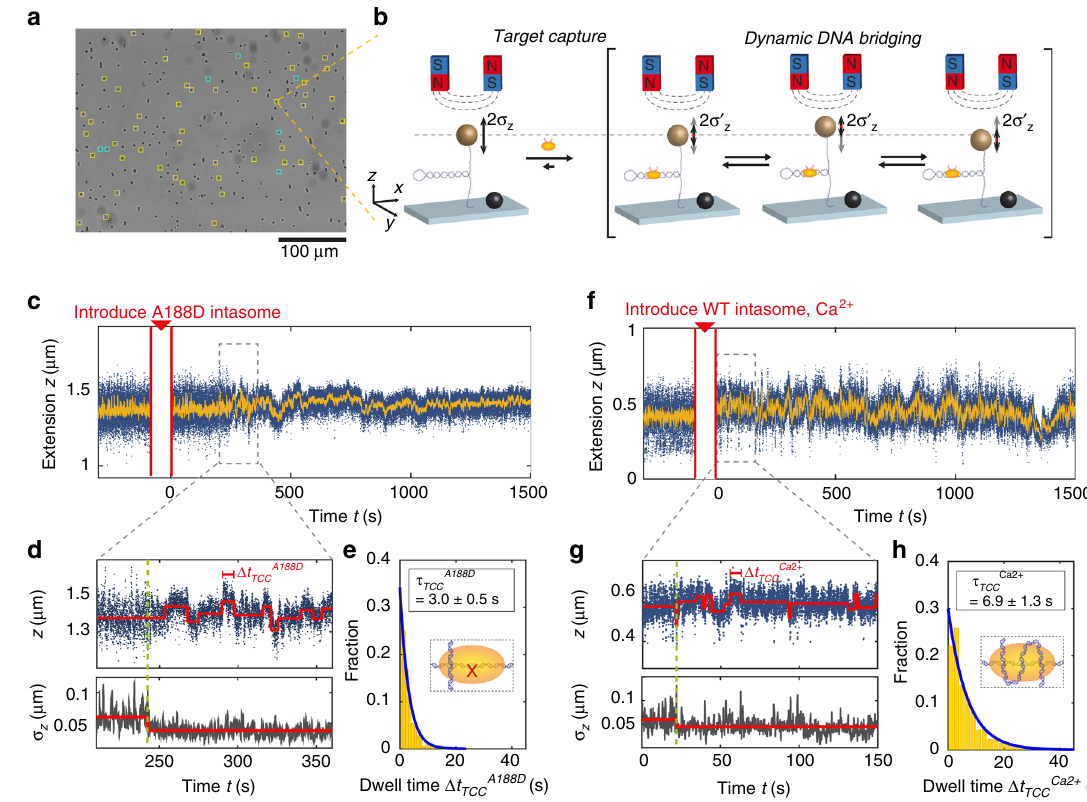
Fig. 3 Magnetic tweezers assay reveals target capture dynamics. a A typical fi eld of view depicting ~50 beads used for tracking (yellow) and reference beads (blue). b DNA tethers are supercoiled using external magnets and exhibit extension fl uctuations with SD σ z . Target capture reduces σ z via DNA bridging. Transient interface unbinding repositions intasomes thereby affecting extension. c Time trace of supercoiled target DNA extension before and after binding A188D CI intasomes (blue: raw data at 58 Hz, yellow: 1 Hz smoothed data). d Enlarged region of c highlighting the onset of dynamic bridging (green dotted line) and coinciding σ z reduction calculated with a 0.5 s moving window (red lines: trace fi tted using step- fi nding algorithm) 24 . e Exponential fi t of Δ t A188D distribution yields a lifetime of auxiliary interfaces τ A188D = 3.0 ± 0.5 s. (Error is 95% CI; n = 724). f Time trace of supercoiled DNA TCC TCC extension and response to binding WT CI in Ca 2 + buffer. g Enlarged region of f shows the onset of dynamic bridging and σ z reduction (green dotted